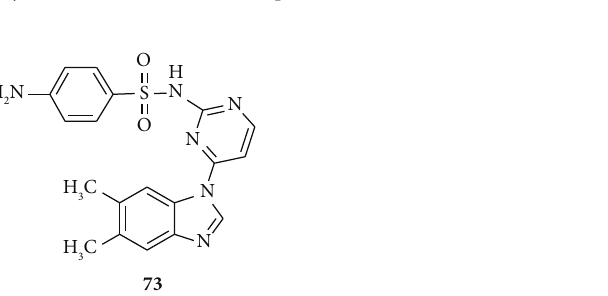
Scheme 12: Synthetic routes towards compound 7 .